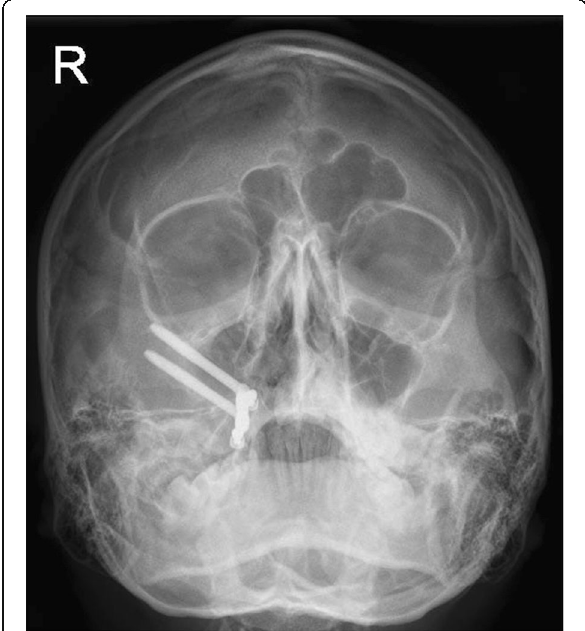
Fig. 11 Facial radiograph at 22-month